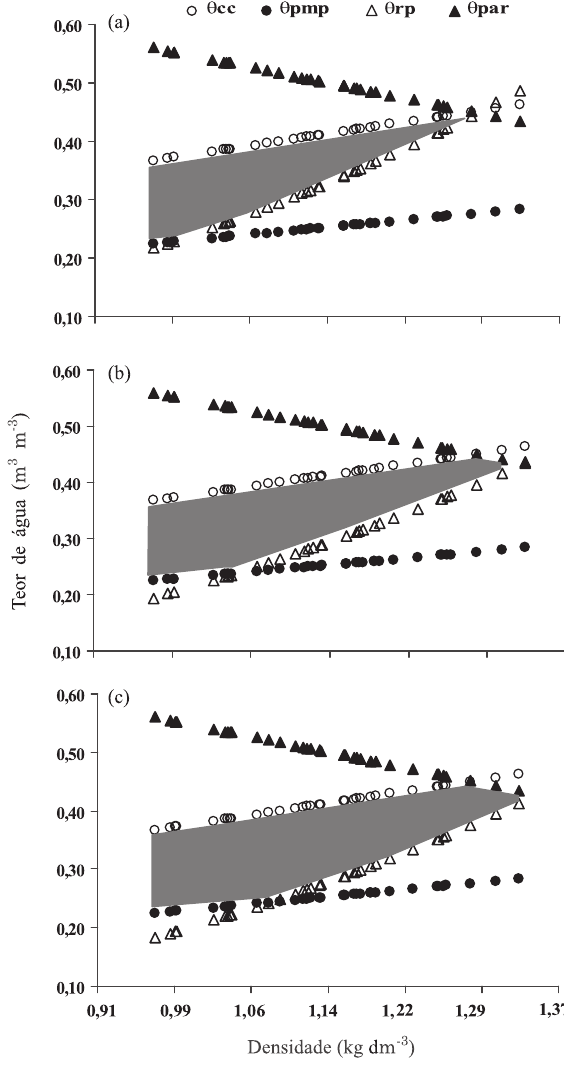
Figura 2. variação dos teores de água do solo na capacidade de campo ( θ cc), ponto de murcha permanente ( θ pmp), porosidade com ar de 10 % ( θ par) e resistência do solo à penetração ( θ rp) de 2,0 mpa (a), 3,5 mpa (b) e 4,6 mpa (c), em função da densidade do solo. a área em cor cinza corresponde ao intervalo hídrico ótimo do